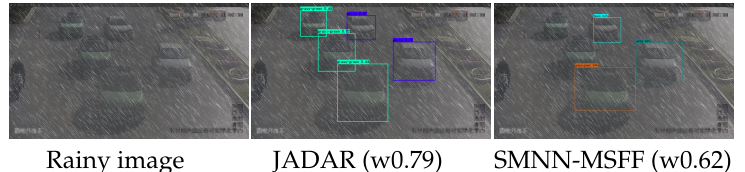
Figure 6. Test results of JADAR and SMNN - MSFF on the Rain Vehicle Color-24 test set. Each subtitle gives object detection method with the corresponding confidence value in